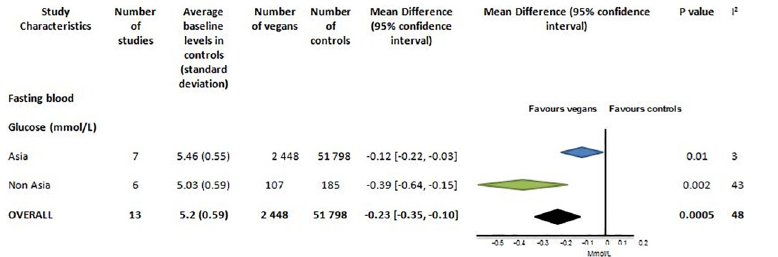
Fig 5. Fasting blood glucose (mmol/L) in vegans compared to omnivores.